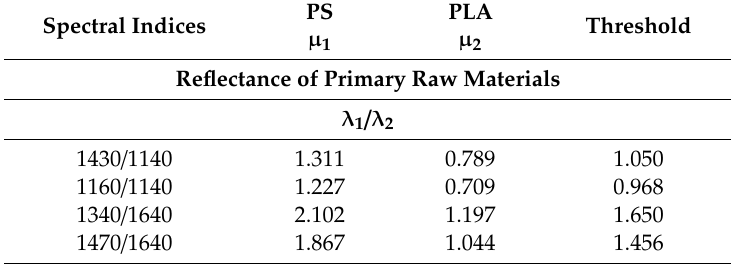
Table 5. First set of spectral indices for the pair PS-PLA. λ 1 / λ 2 ( λ 1 – λ 2 ) are computed as the ratio among reflectance values at wavelengths λ 1 and λ 2